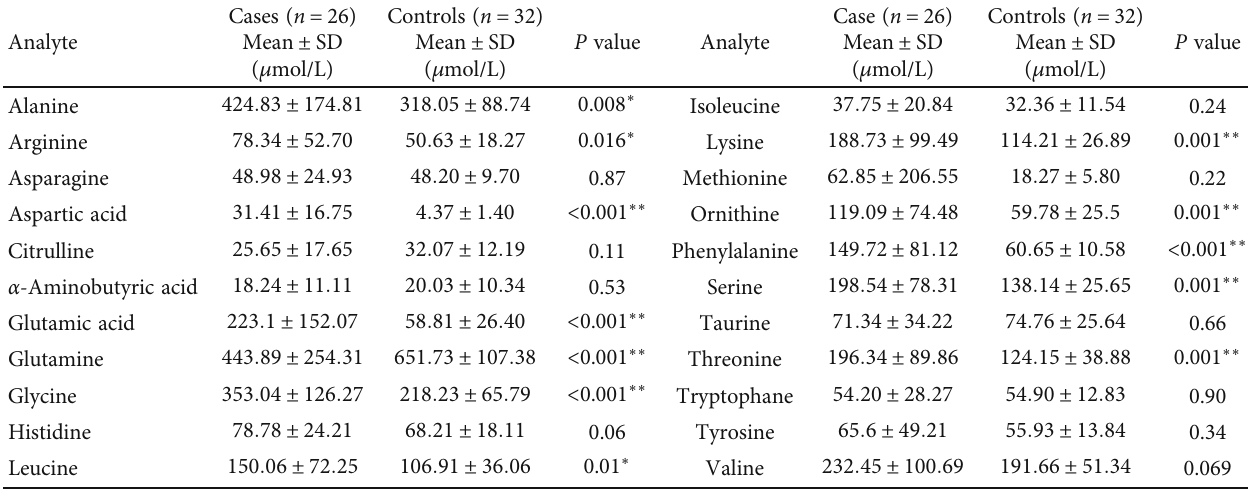
Table 1: Plasma free amino acids concentration in COVID-19 patients (cases) and